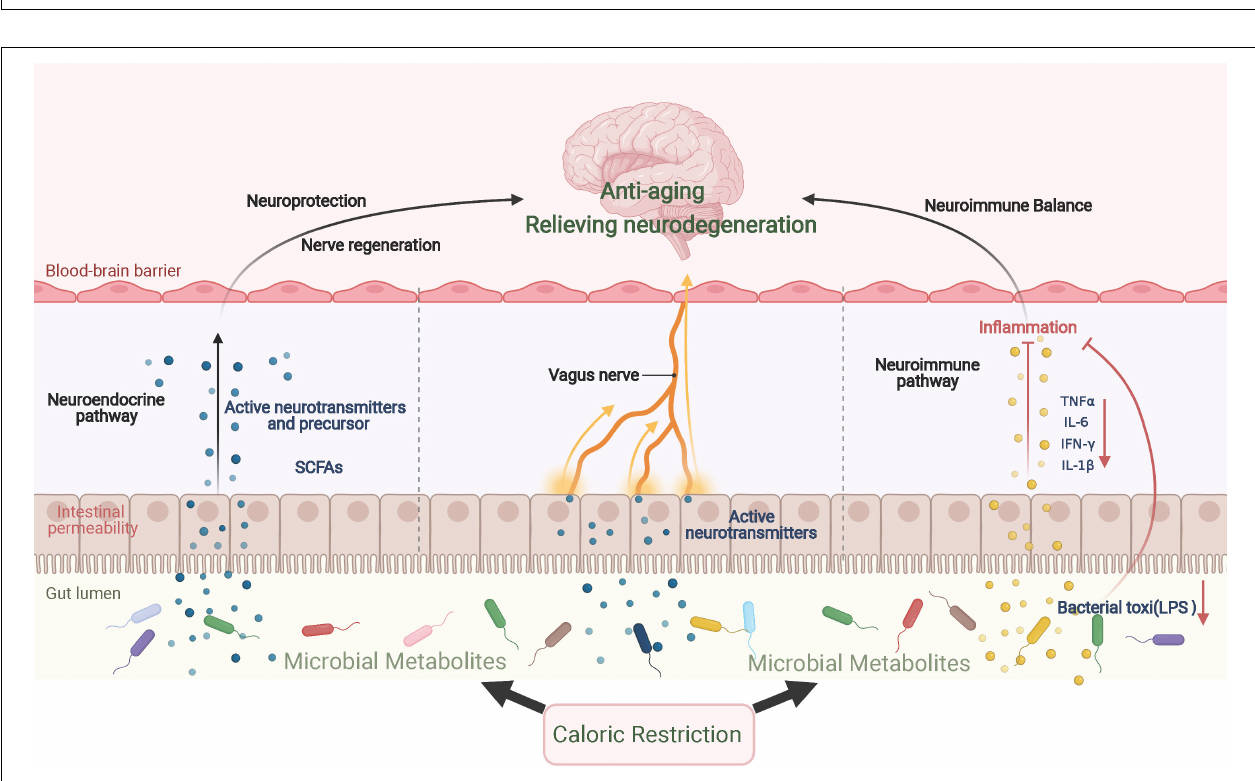
FIGURE 3 | CR improves aging and neurodegenerative diseases via the gut–brain axis. CR significantly changes the composition and metabolism of gut microbes, which results in the production of various neurotransmitters and their precursors, inducing a neuroprotection effect. When inflammatory cytokine levels are repressed locally, neuroinflammation is further relieved. In addition to immune and endocrine regulation, gut microbes send signals directly to the central region via vagal afferent nerves. SCFAs, short-chain fatty acids.